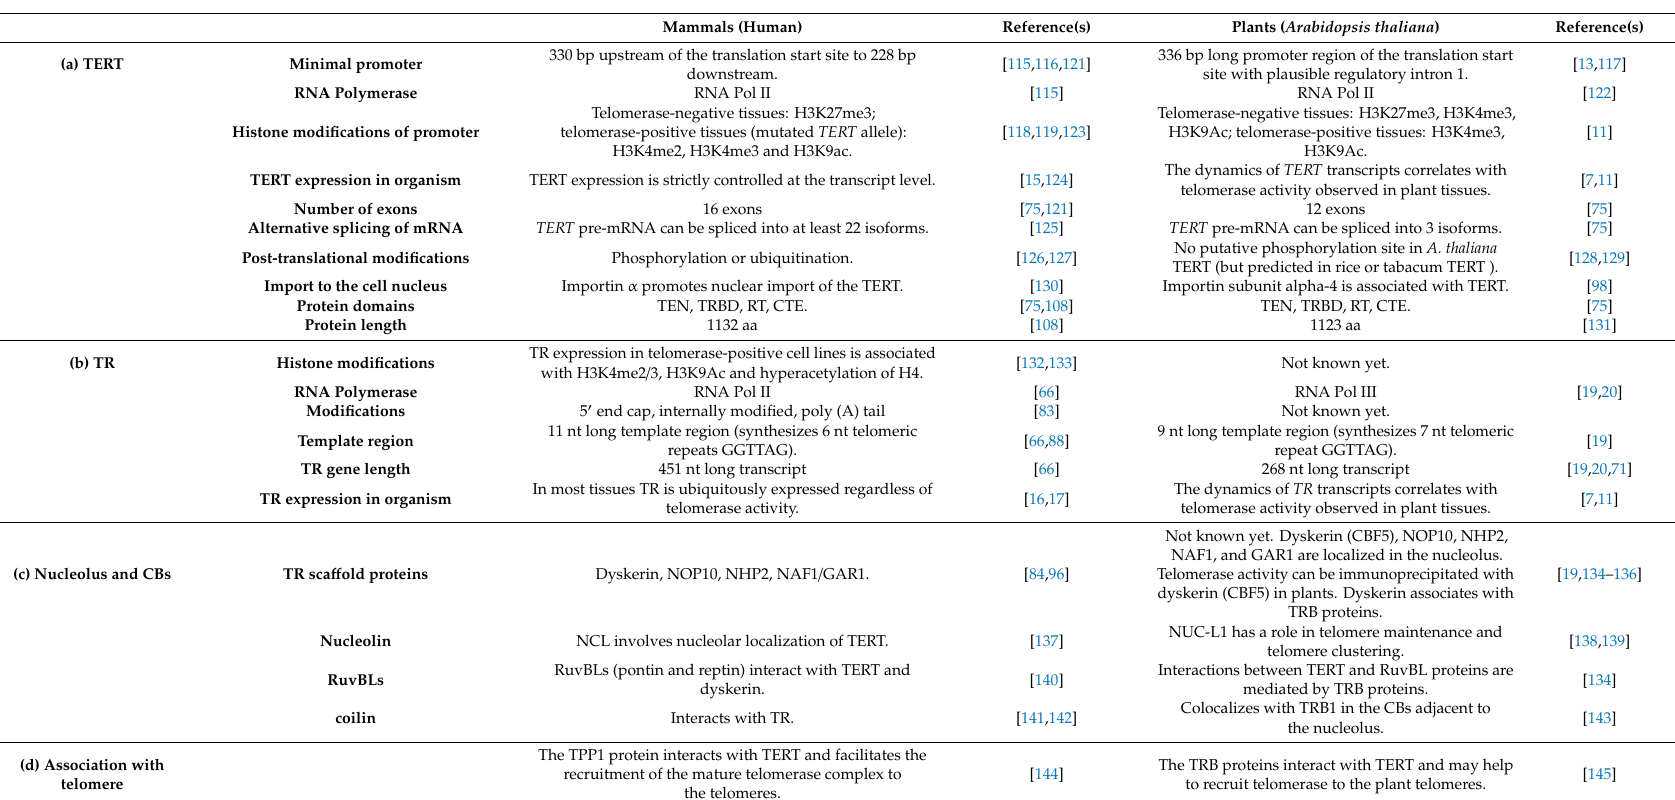
Table 1. Human and Arabidopsis telomerase assembly—a comparative overview (a–d classification corresponds to Figure 4). Mammals (Human)